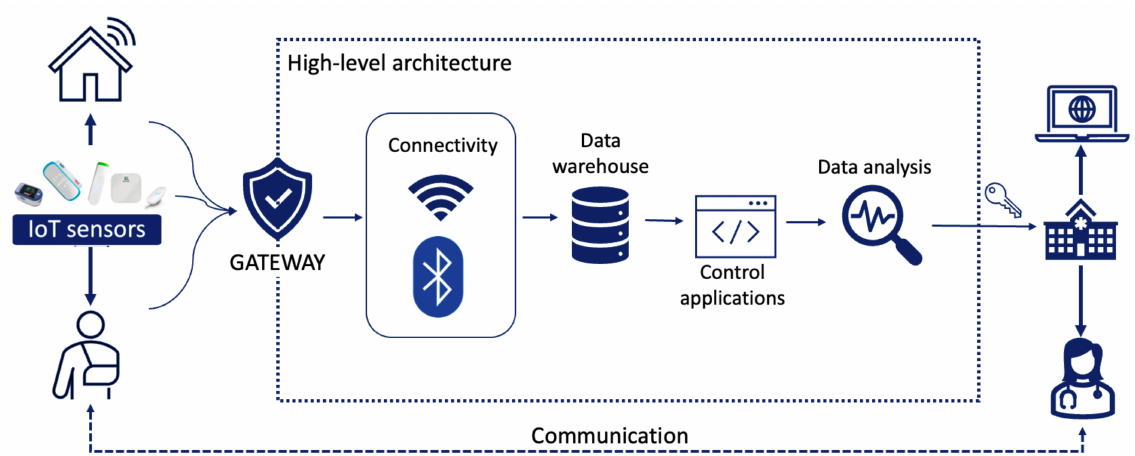
Figure 1. Process and IoT devices